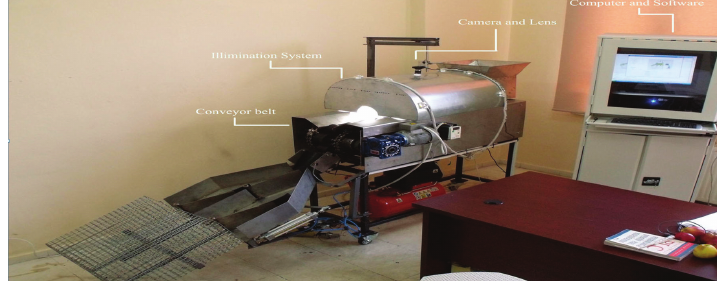
Figure 2: Machine vision system.